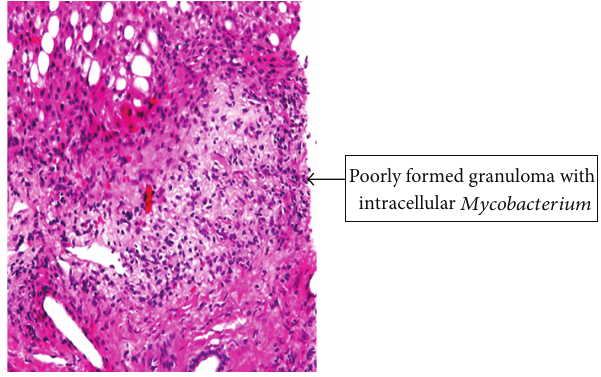
Figure 2: Histopathology of liver biopsy.